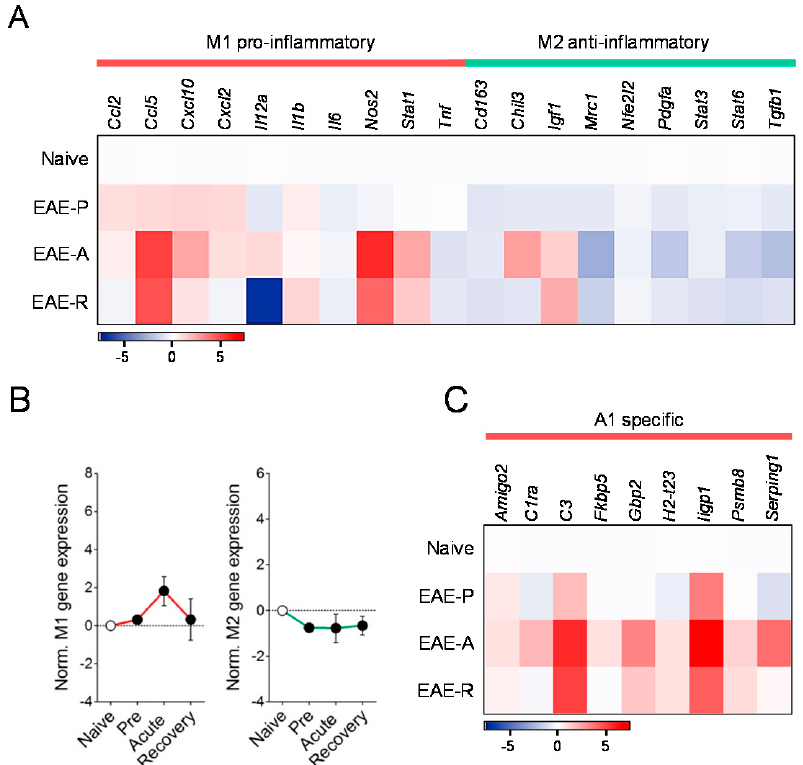
Figure 4. Pro-inflammatory and anti-inflammatory gene expressions in microglia isolated during EAE. ( A ) Heat map depicting the mean expression of M1 and M2 phenotype associated genes in microglial cells purified from mice at presymptomatic (EAE-P), acute (EAE-A) and recovery (EAE-R) stages of EAE as determined by RT-qPCR. ( B ) Analysis of normalized gene expression by one-way ANOVA determined no overall deregulation of M1 or M2 gene transcripts during disease progression. ( C ) Mean expression of A1 neurotoxic genes in microglial cells during the time-course of EAE. Fold changes in the relative expression compared to naïve microglia were determined as log 2 ( n = 5–6 mice group) Pre, Presymptomatic. N.S., not statistically significant. * p < 0.05; ** p < 0.01; *** p <